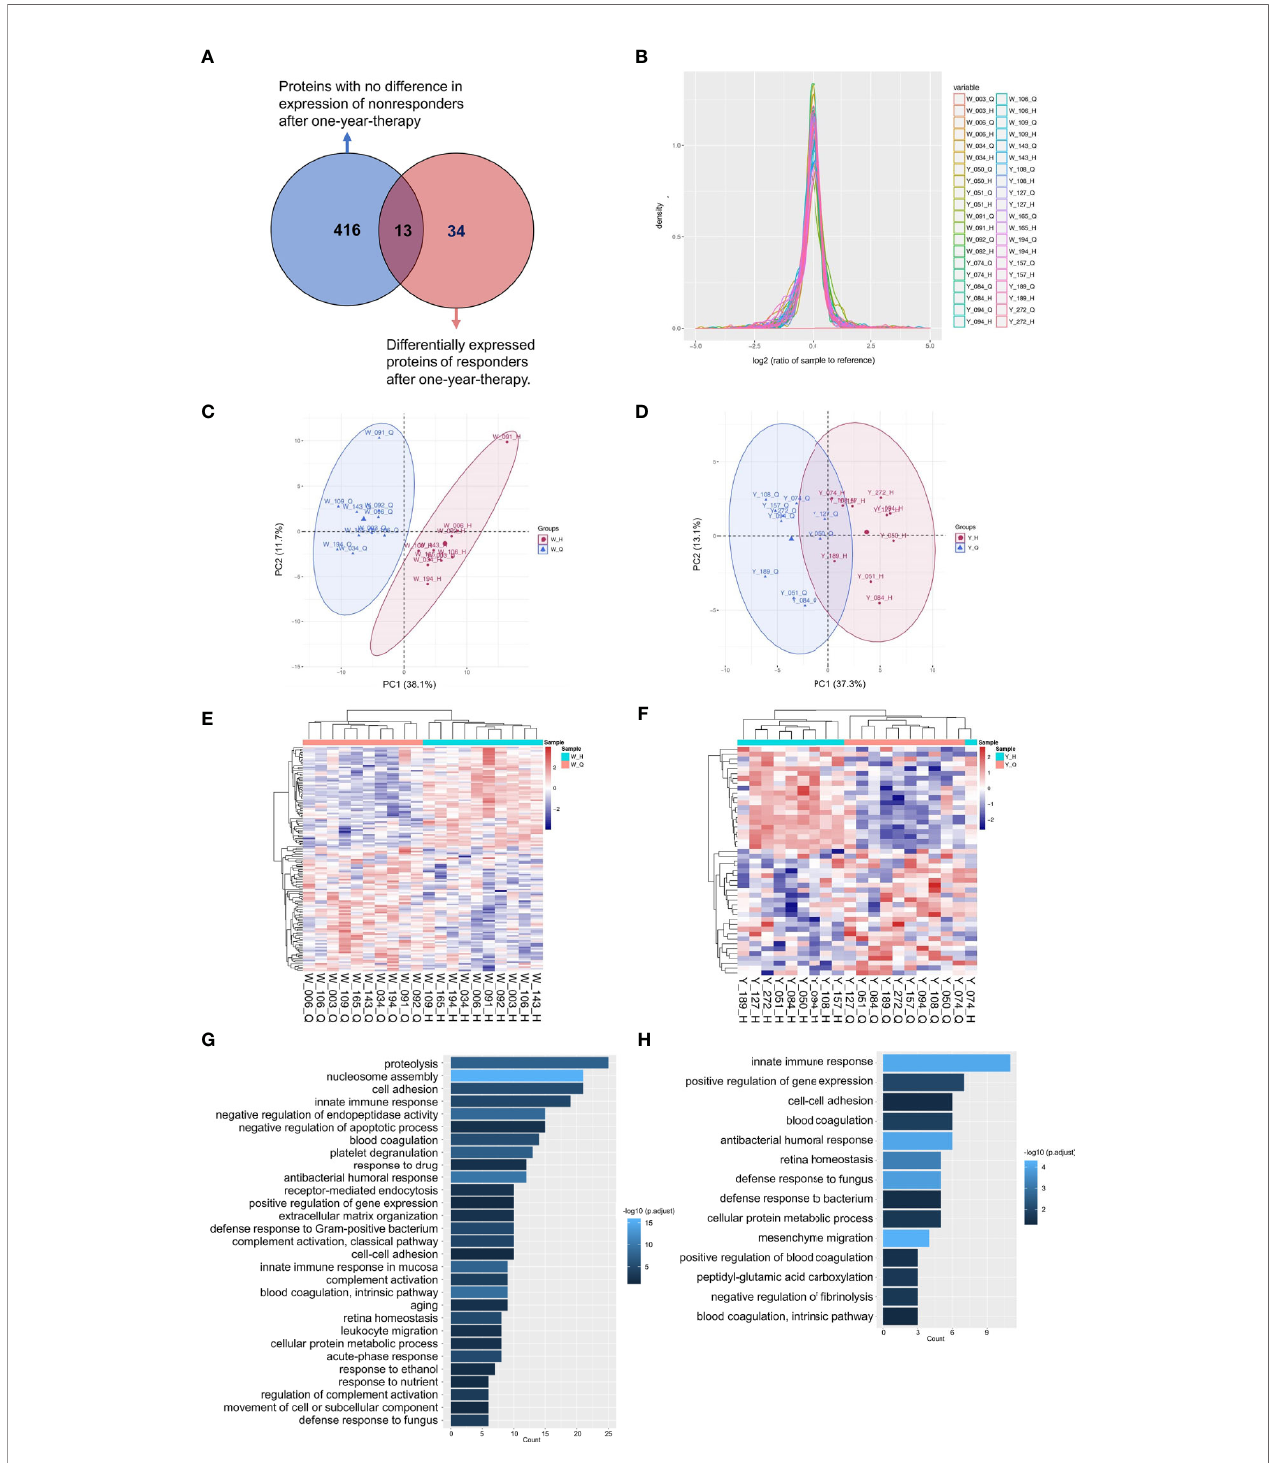
FIGURE 3 | Characterization of serum proteins using quantitative MS. (A) Venn diagram depicts the overlap between proteins with no difference in expression of non-responders and differentially expressed proteins of responders after 1-year therapy. (B) The unimodal distributions of the ratios of samples to the internal reference. Principal-component analysis of serum proteins before and after 1-year allergen immunotherapy (AIT) in non-responder cohort (C) and responder cohort (D) based on tandem mass tags (TMT) global data. The heat map and Gene Ontology biological processes enrichment of the signi fi cantly differentially expressed proteins (P-adjusted < 0.05, t test) in AIT non-responders (E, G) and responders (F, H) after 1-year therapy. *W_Q: non-responder, before AIT; W_H: non- responder, after AIT; Y_Q: responder, before AIT; Y_H: responder, after